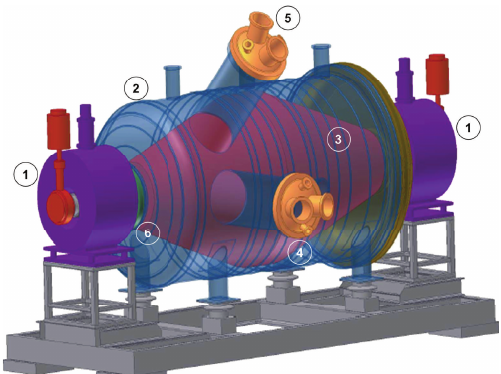
Figure 20: Photograph of the spectrometer transport during the final careful maneuvering through the nearby village of Leopold- shafen in November 2006. Due to its size, it could not be transported to Karlsruhe on motorways, but had to travel nearly 9000 km through the Danube River, the Black Sea, the Mediterranean Sea, the Atlantic Ocean, the North Sea, and the River Rhine